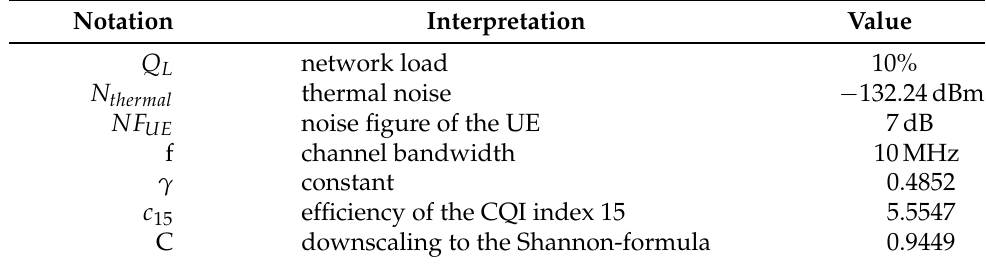
Table 1. Symbols used in the calculations.